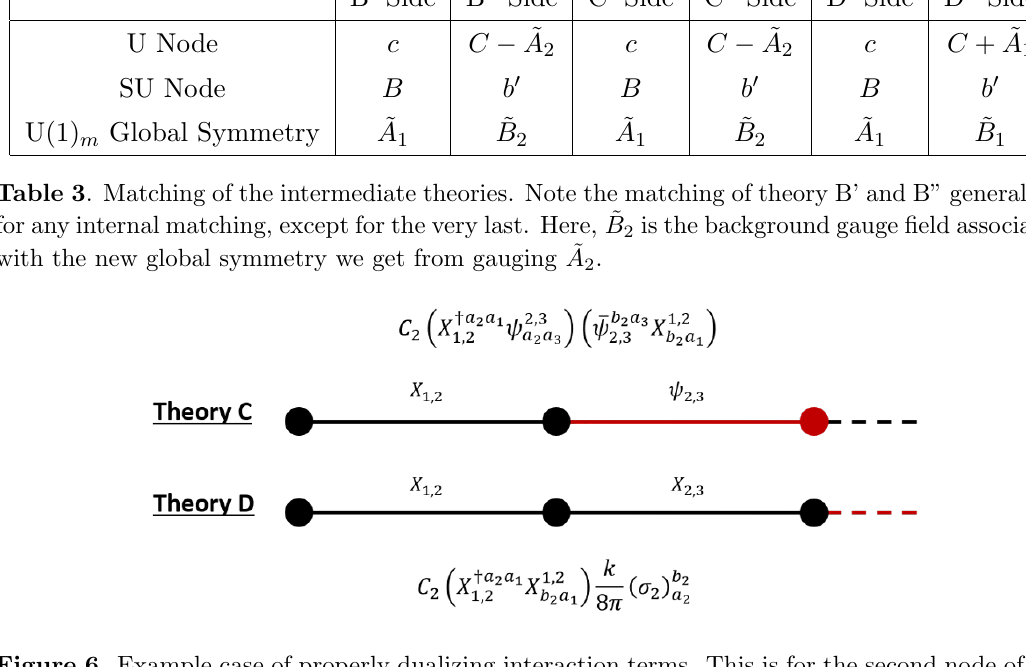
Figure 6 . Example case of properly dualizing interaction terms. This is for the second node of the four node case considered in the main text in section 3.2 and also pictures in (cid:12)gure